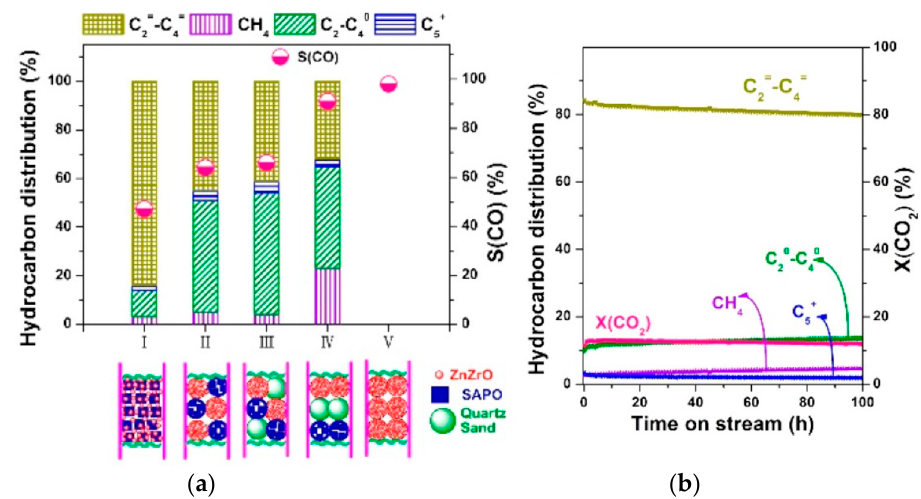
Figure 20. ( a ) CO 2 hydrogenation over the bifunctional composite catalyst ZnZrO/SAPO-34, with the effect of the prox- imity of the active components of ZnZrO and SAPO-34 on the catalytic performance. ( b ) The catalytic stability of the catalyst ZnZrO/SAPO-34 (testing conditions: T = 653K, P = 2 MPa, and GHSV = 3600 mL g cat − 1 h − 1 ). Adapted with permis- sion from ref. [13]. Copyright 2017 American Chemical